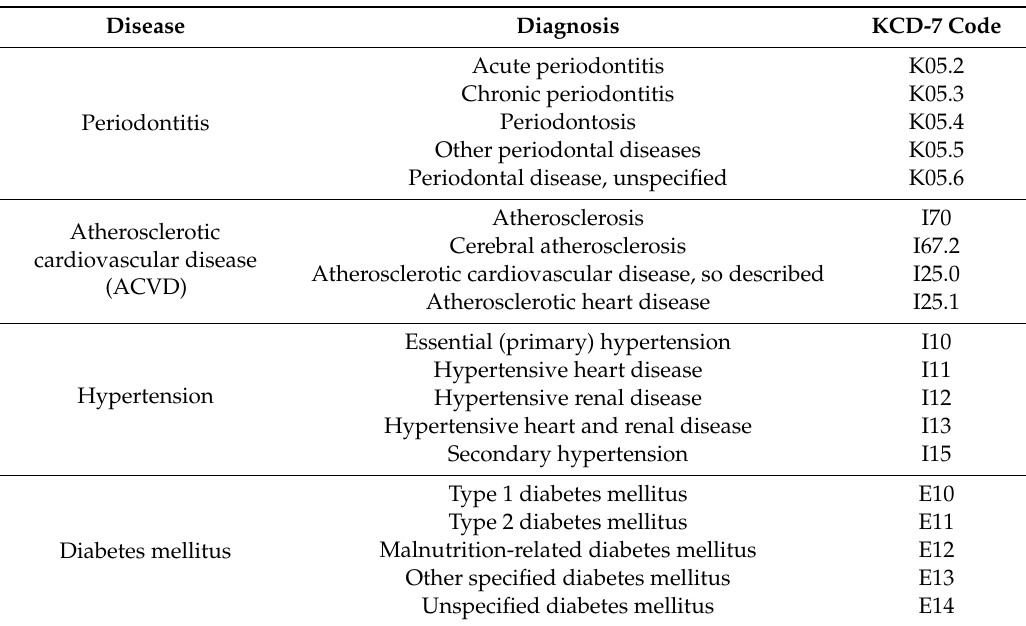
Table 1. KCD-7 codes used in disease definition.